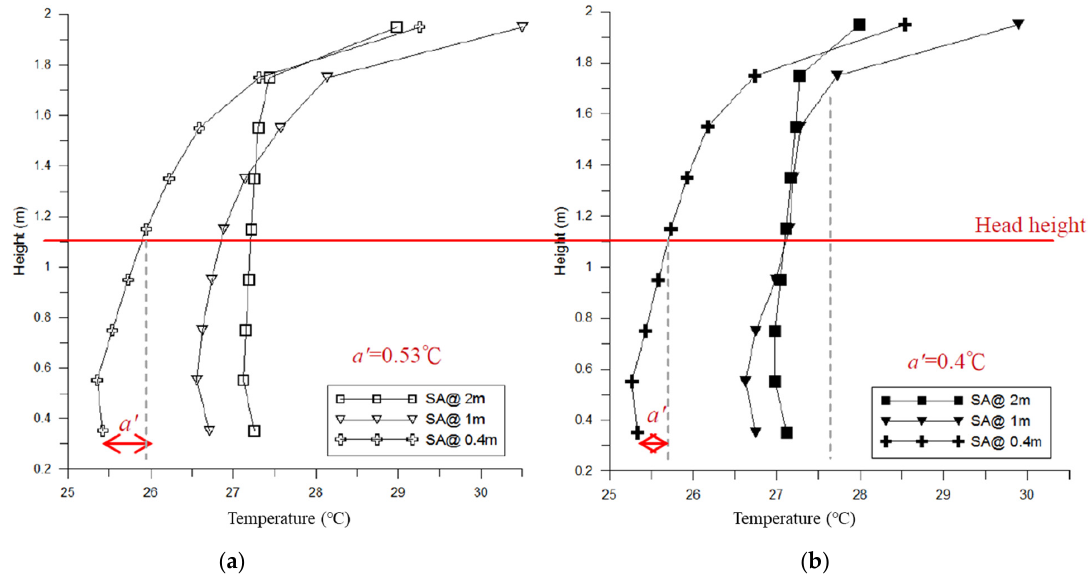
Figure 20. Vertical temperature difference with various handrail and SA heights. ( a ) 1.1-m handrail. ( b ) 1.9-m handrail. Figure 20 indicates that hot air rose along the handrail to the upper part of the atrium